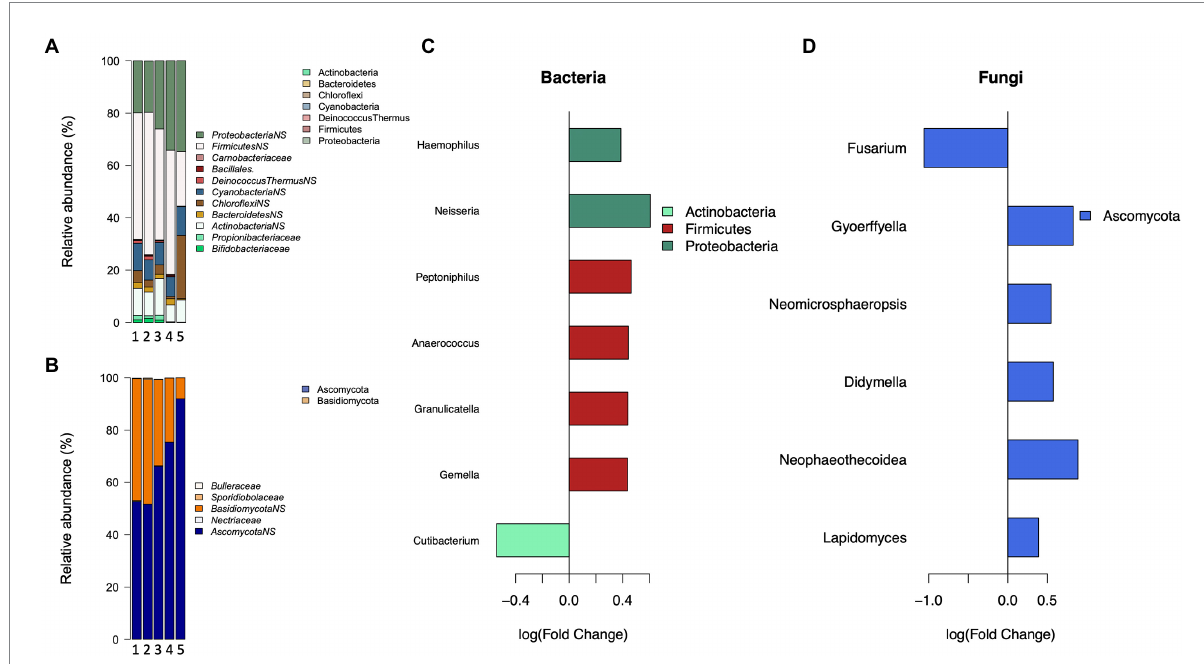
FIGURE 3 The association between the number of children in the home and bacterial and fungal communities. Mean relative abundance of significantly and non-significantly (NS, p >0.05) associated bacterial (A) , and fungal (C) families by the number of children in the home. The estimated effect of the presence of more than one child in the home on (B) bacterial and (D) fungal